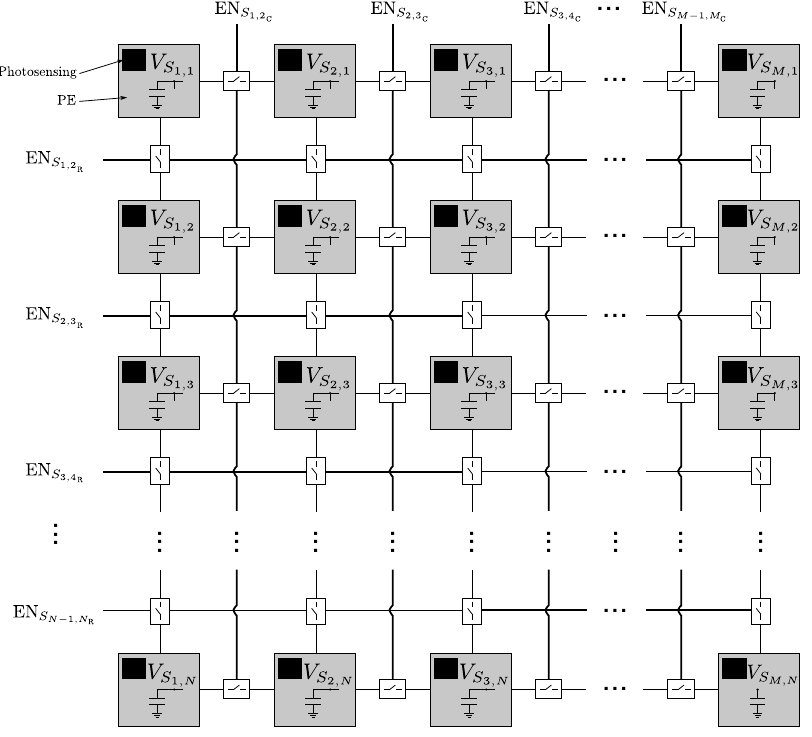
Figure 5. Simplified scheme of how the charge redistribution can be reconfigured column-wise and row-wise from the periphery of the proposed focal-plane array.